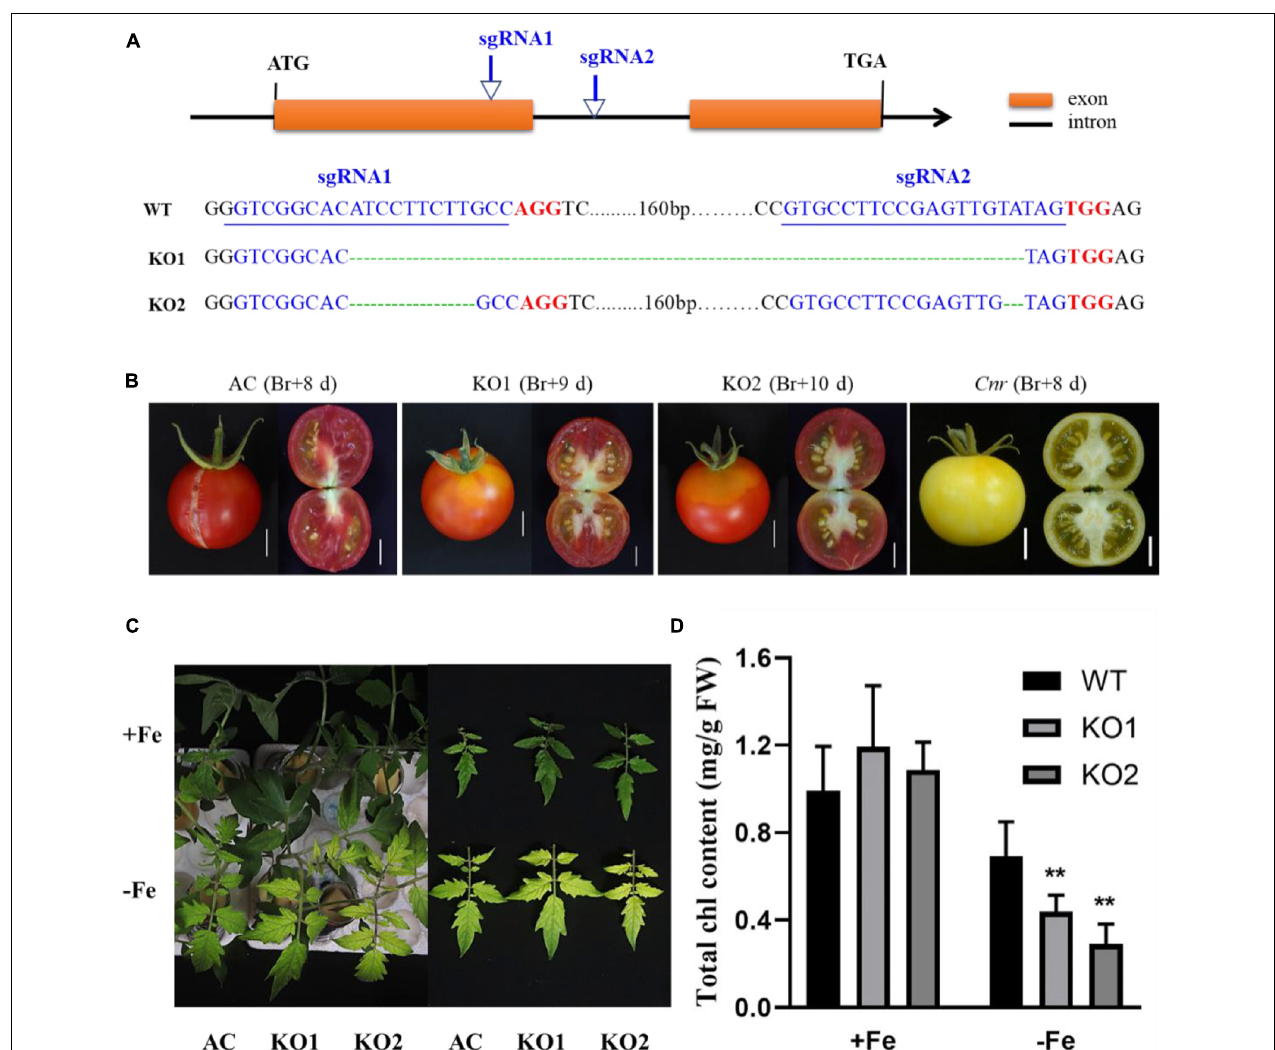
FIGURE 5 | Construction of SlSPL-CNR knockout (KO) mutants and relative physiological responses under Fe-deficiency. (A) Schematic illustration of CRISPR/Cas9-mediated mutation pattern in SlSPL-CNR gene. The two sgRNAs target sites in SlSPL-CNR coding sequence (138–160 bp for sgRNA1, 325–347 bp for sgRNA2), related PAM sites and CRISPR edited sites are represented in blue, red, and green, respectively. Via Sanger sequencing, KO1 displayed a frame-shift type mutation with 196-bp deletion located at 146–341 bp between two target sites, while KO2 displayed an in-frame type mutation with 9-bp deletion located in the first target site and 2-bp deletion located in the second target site, respectively. (B) Fruit phenotypes of AC, two independent KO lines KO1 and KO2. Br, break. Bar = 1 cm. (C) Fe-deficiency-induced chlorosis in newly formed leaves of AC and two KO lines after 9 days under +Fe or –Fe condition. (D) Chlorophyll content in newly formed leaves of AC and two KO lines. A significant reduction of chlorophyll levels was seen in two KO lines when compared with AC under Fe deficiency (Tukey’s test, P ≤ 0.05, as indicated by asterisks). Data are shown as means ± SD ( n = 4 for biological repeats).